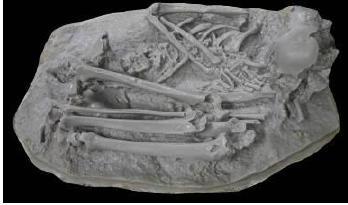
Figure 12. Resin replication of PR